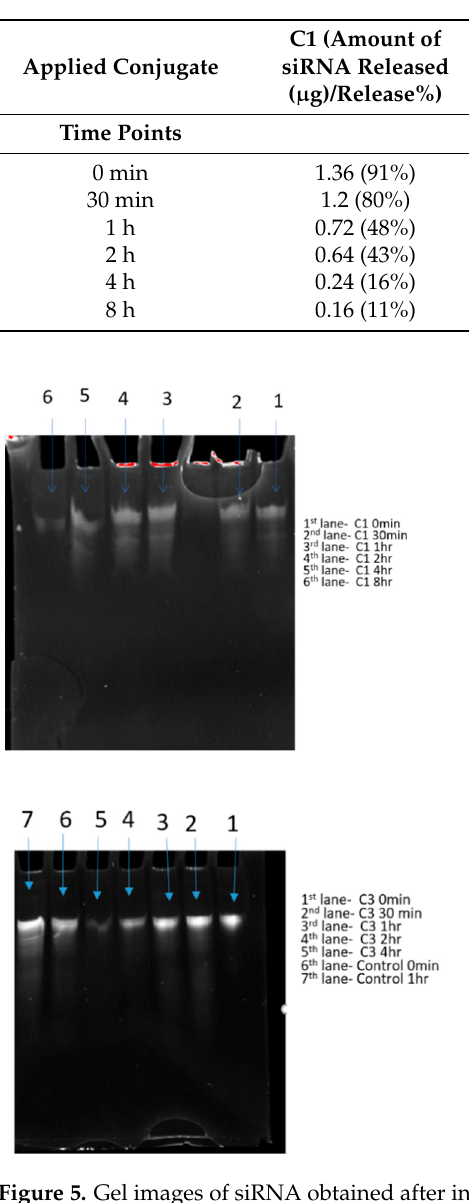
Figure 5. Gel images of siRNA obtained after in vitro stability study. We studied solubilized HiPco-SWCNTs and HiPco-SWCNTs by scanning electron microscopy (SEM; Figure 6). Solubilized HiPco-SWCNTs displayed a regular spherical morphology (Figure 6) with an average diameter of 343.5 ± 42.58 nm (Table 4) and a very narrow size distribution (polydispersity index (PDI)